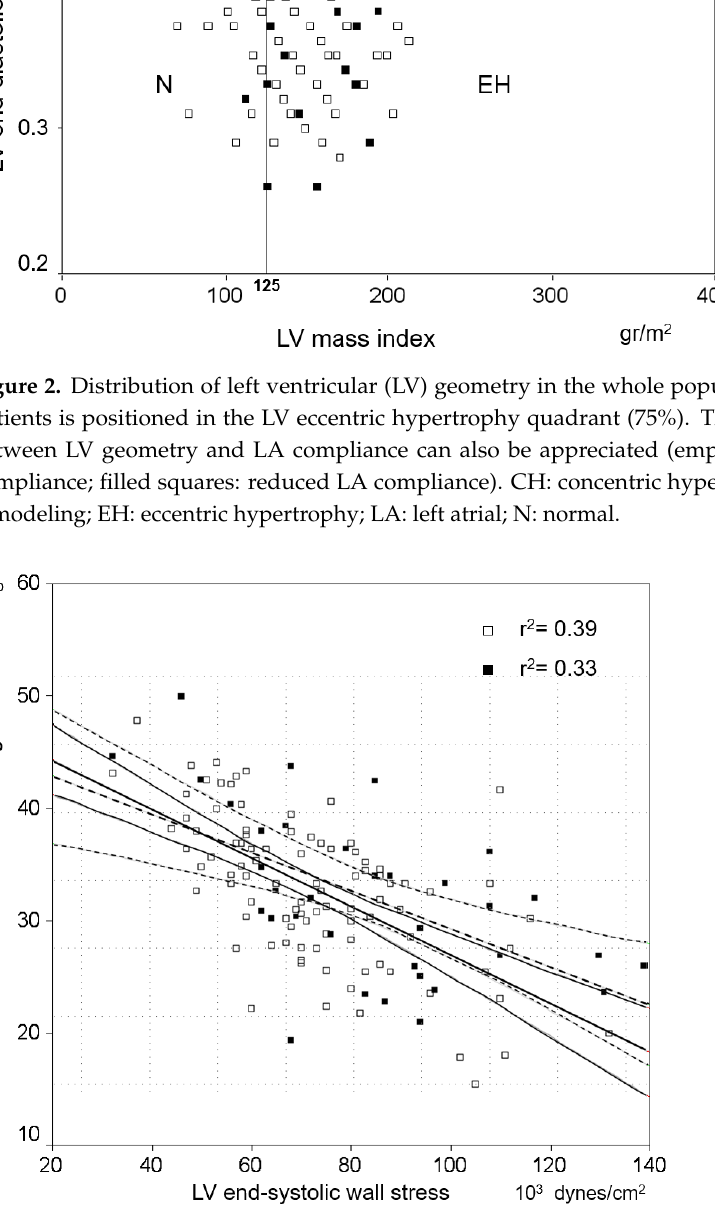
Figure 3. Distribution of left ventricular (LV) geometry in the whole population. The majority of patients is positioned in the LV eccentric hypertrophy quadrant (75%). The absence of a relation between LV geometry and LA compliance can also be appreciated (empty squares: normal LA com- pliance; filled squares: reduced LA compliance). CH: concentric hypertrophy; CR: concentric re- modeling; EH: eccentric hypertrophy; LA: left atrial; N: normal. Different from those without MetS, in subjects with MetS, early filling was decreased and followed by a compensatory increase in late filling, consistent with diastolic dysfunc- tion due to prolonged relaxation (Table 2).